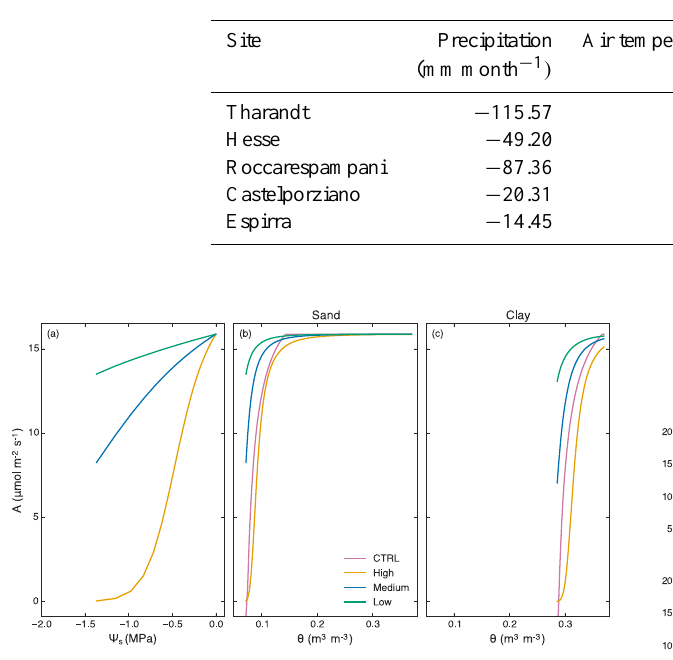
Figure 2. Modelled impact of drought on the assimilation rate ( A ), shown as (a) a function of volumetric soil moisture content ( θ ) and (b) soil water potential ( (cid:57) S ) for a sand and clay soil.